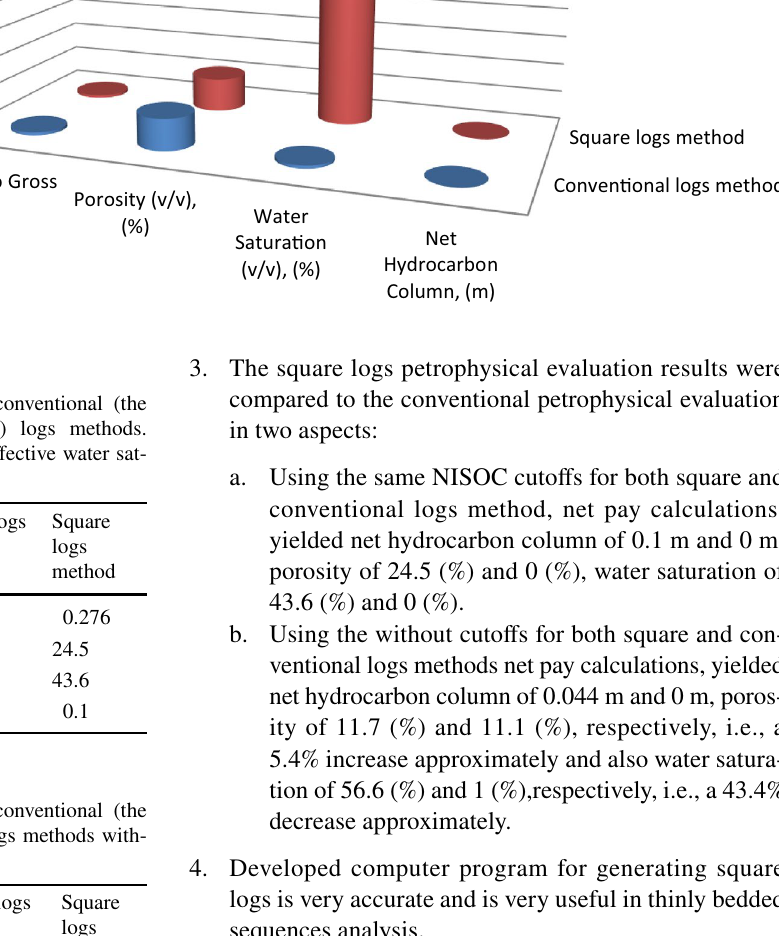
Fig. 15 Petrophysical parameter without consideration of the NISOC cutoffs